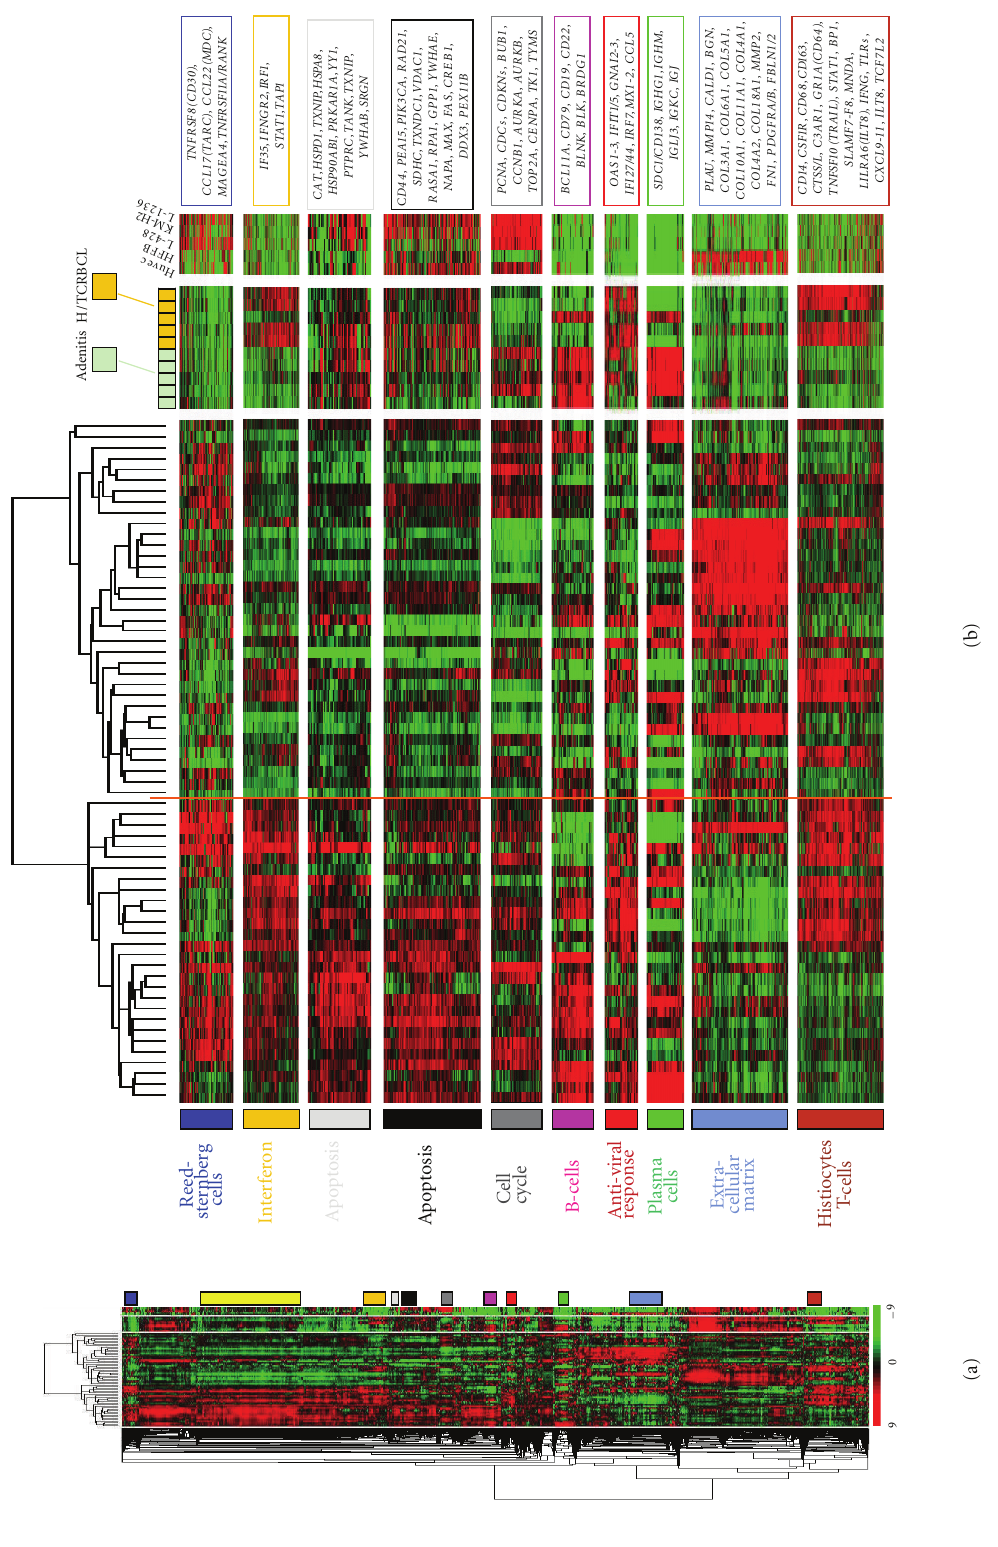
Figure 1: Global gene expression profiling of cHL samples and control